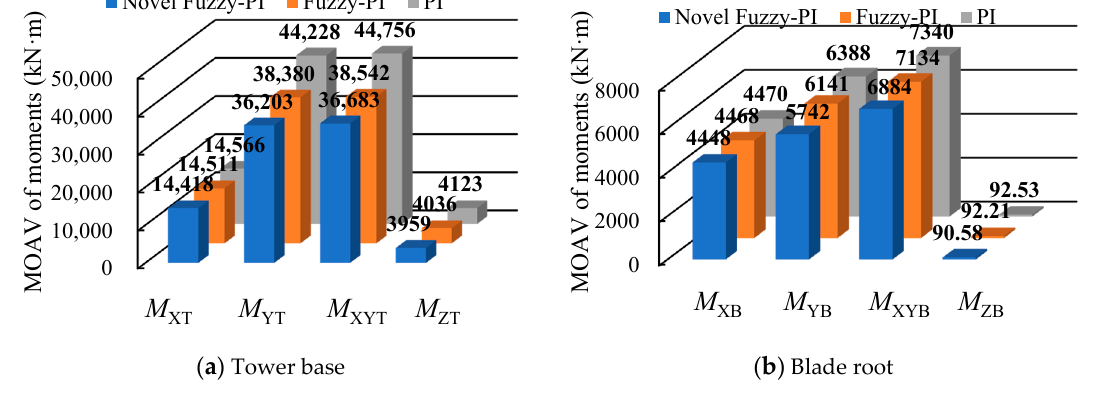
Figure 11. Moments under extreme turbulent wind conditions. Table 7. Analysis of ultimate loads under extreme turbulent wind conditions.